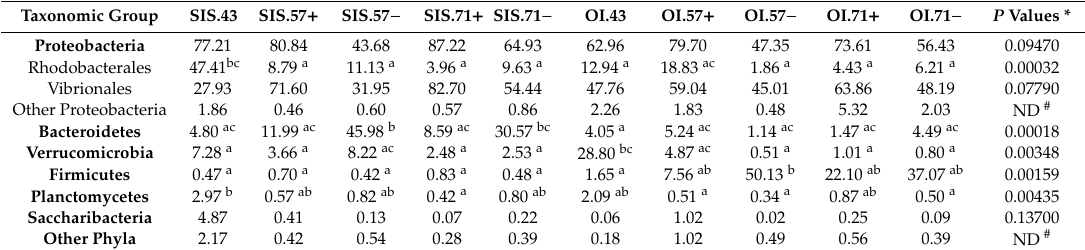
Table 2. Mean relative abundance (%) of main bacterial taxonomic groups in the intestinal tract of whiteleg shrimp from two genetic lines (SIS or OI), in the presence ( + ) or absence ( − ) of probiotic treatment, at three di ff erent sampling time points (d43, d57 and d71). Taxonomic